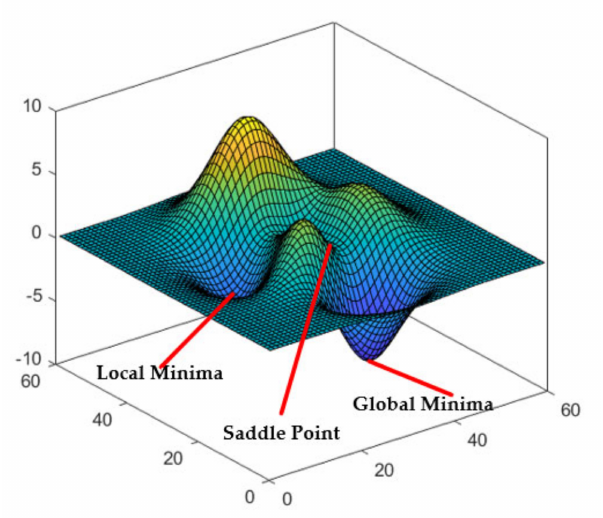
Figure 20. The local minimum, global minimum and saddle point in loss